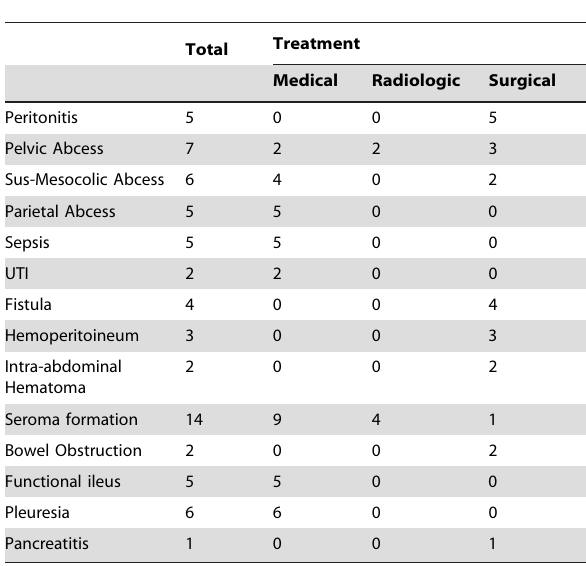
Table 4. Complications and their